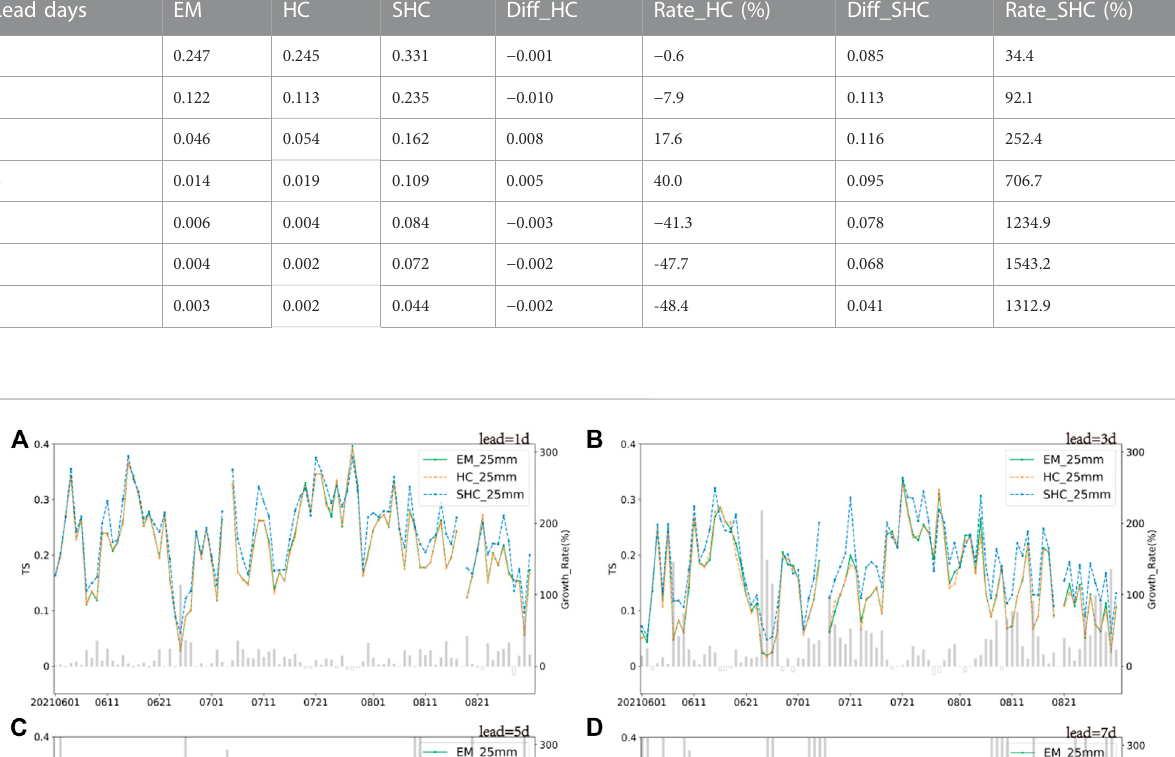
TABLE 4 Same as Table 1, but for ETS related to 100 mm precipitation (order of magnitude: 10 − 1 ). Lead days EM HC SHC